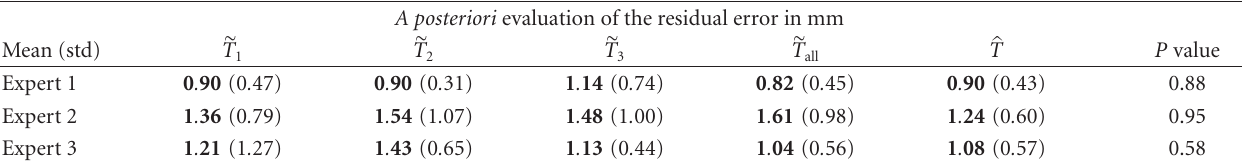
Table 3: A posteriori evaluation of the residual error in mm in patient 2 by all experts. Our automatic registration (cid:2) T obtains no statistically di ff erent result compared to transformations extracted from experts estimation.